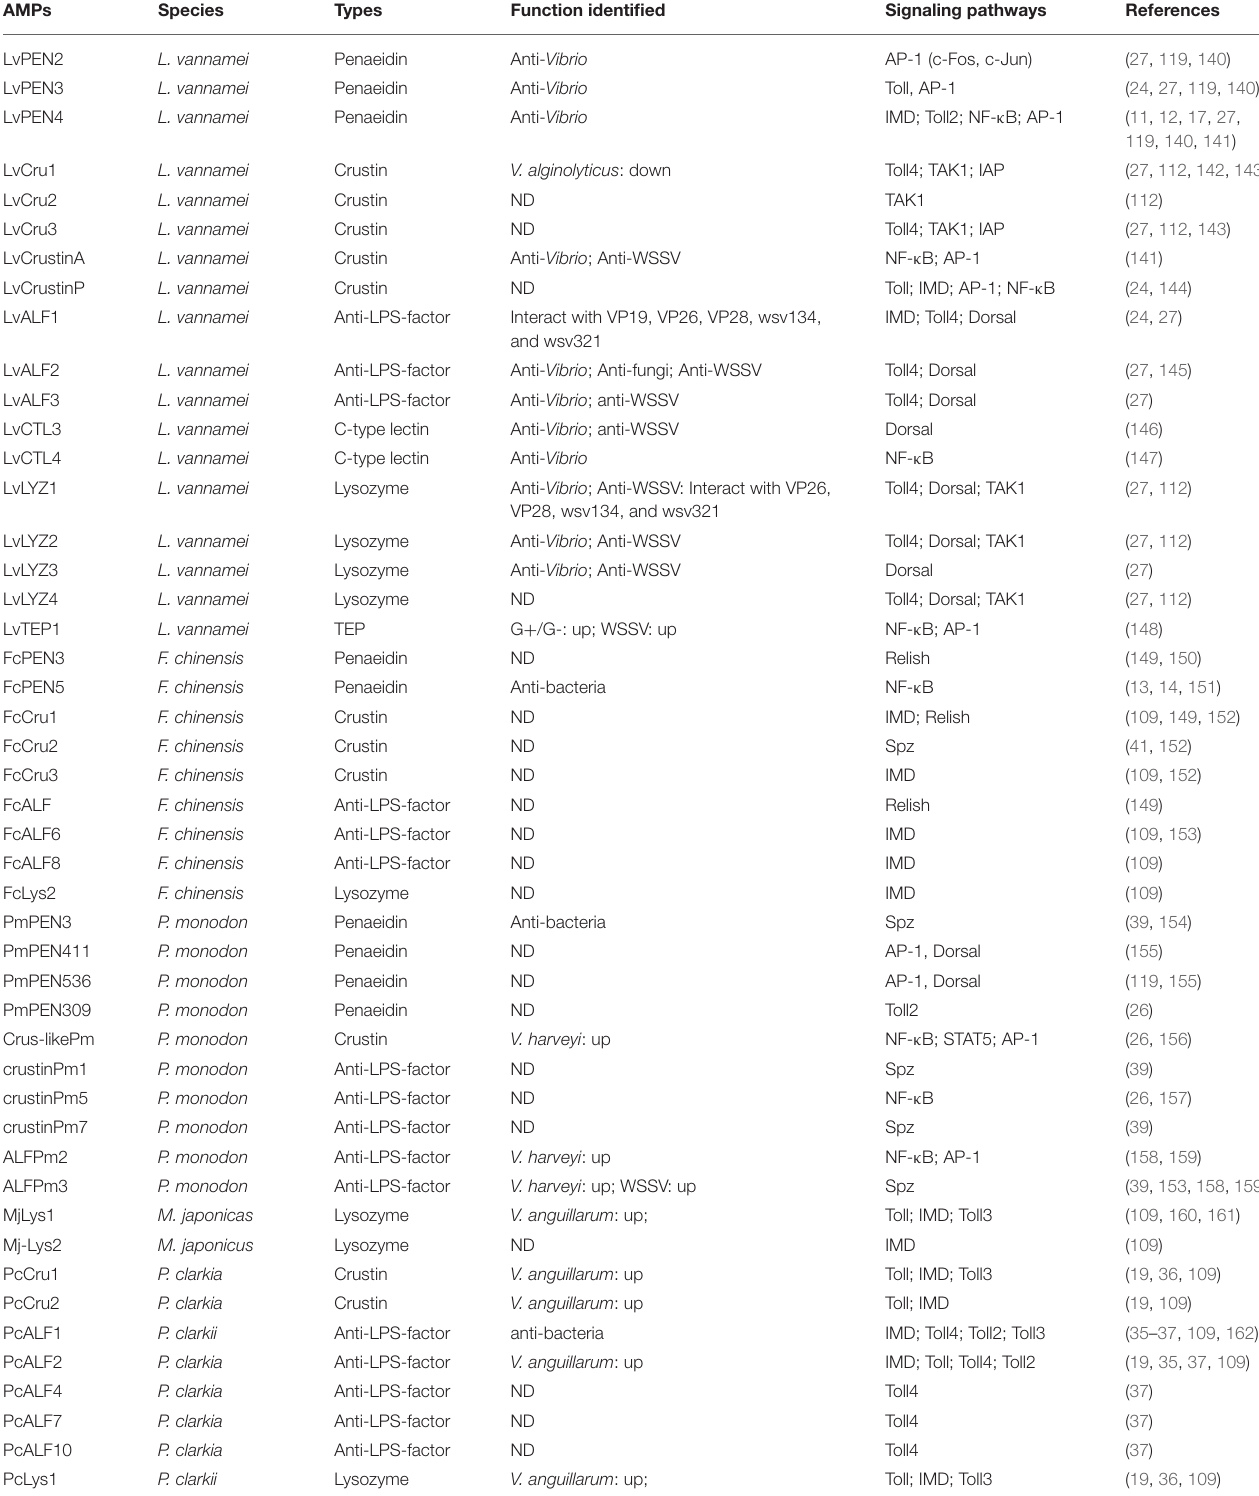
TABLE 3 | AMPs or effectors related to NF- κ B pathways identified in shrimps.